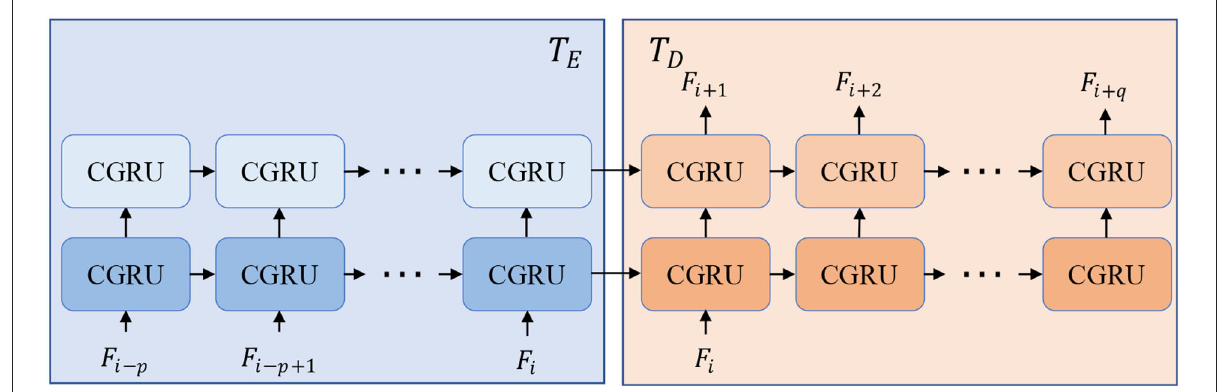
FIGURE2 Structure of time-series processing unit T that is composed of a time-series encoder T E and decoder T D . With T E and T D , our model can predict different lengths of outputs with length-changeable